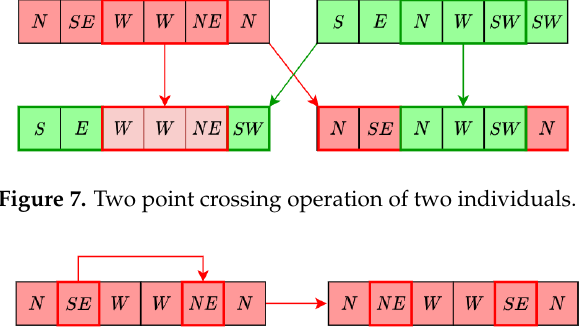
Figure 8. 1-bit mutation of an individual.